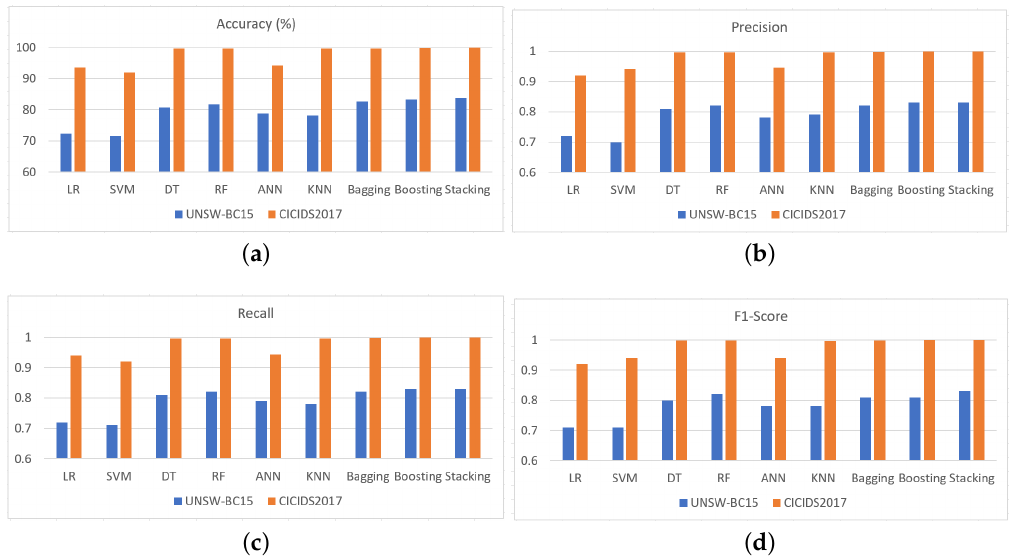
Figure 3. Performance evaluation of the proposed method in terms of: ( a ) accuracy; ( b ) precision; ( c ) recall; and ( d )